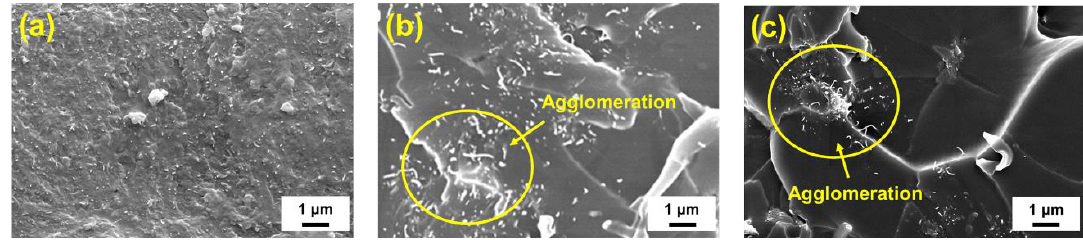
Figure 16. Enlarged SEM images of the quasi-static fracture surface for the studied nanocomposites with the MWCNT:GNP ratio of ( a ) 1:9, ( b ) 3:7 and ( c ) 9:1.